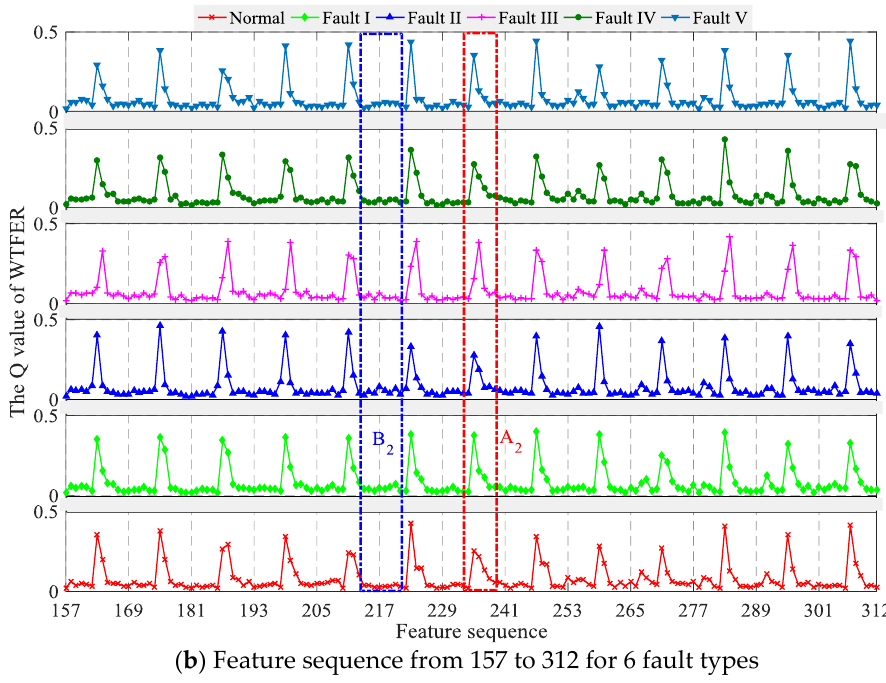
Figure 6. Feature description. A1, A2, B1, B2 represents a length of feature sequence (65~71th, 233~239th, 44~52th, 214~222th feature sequence, respectively).